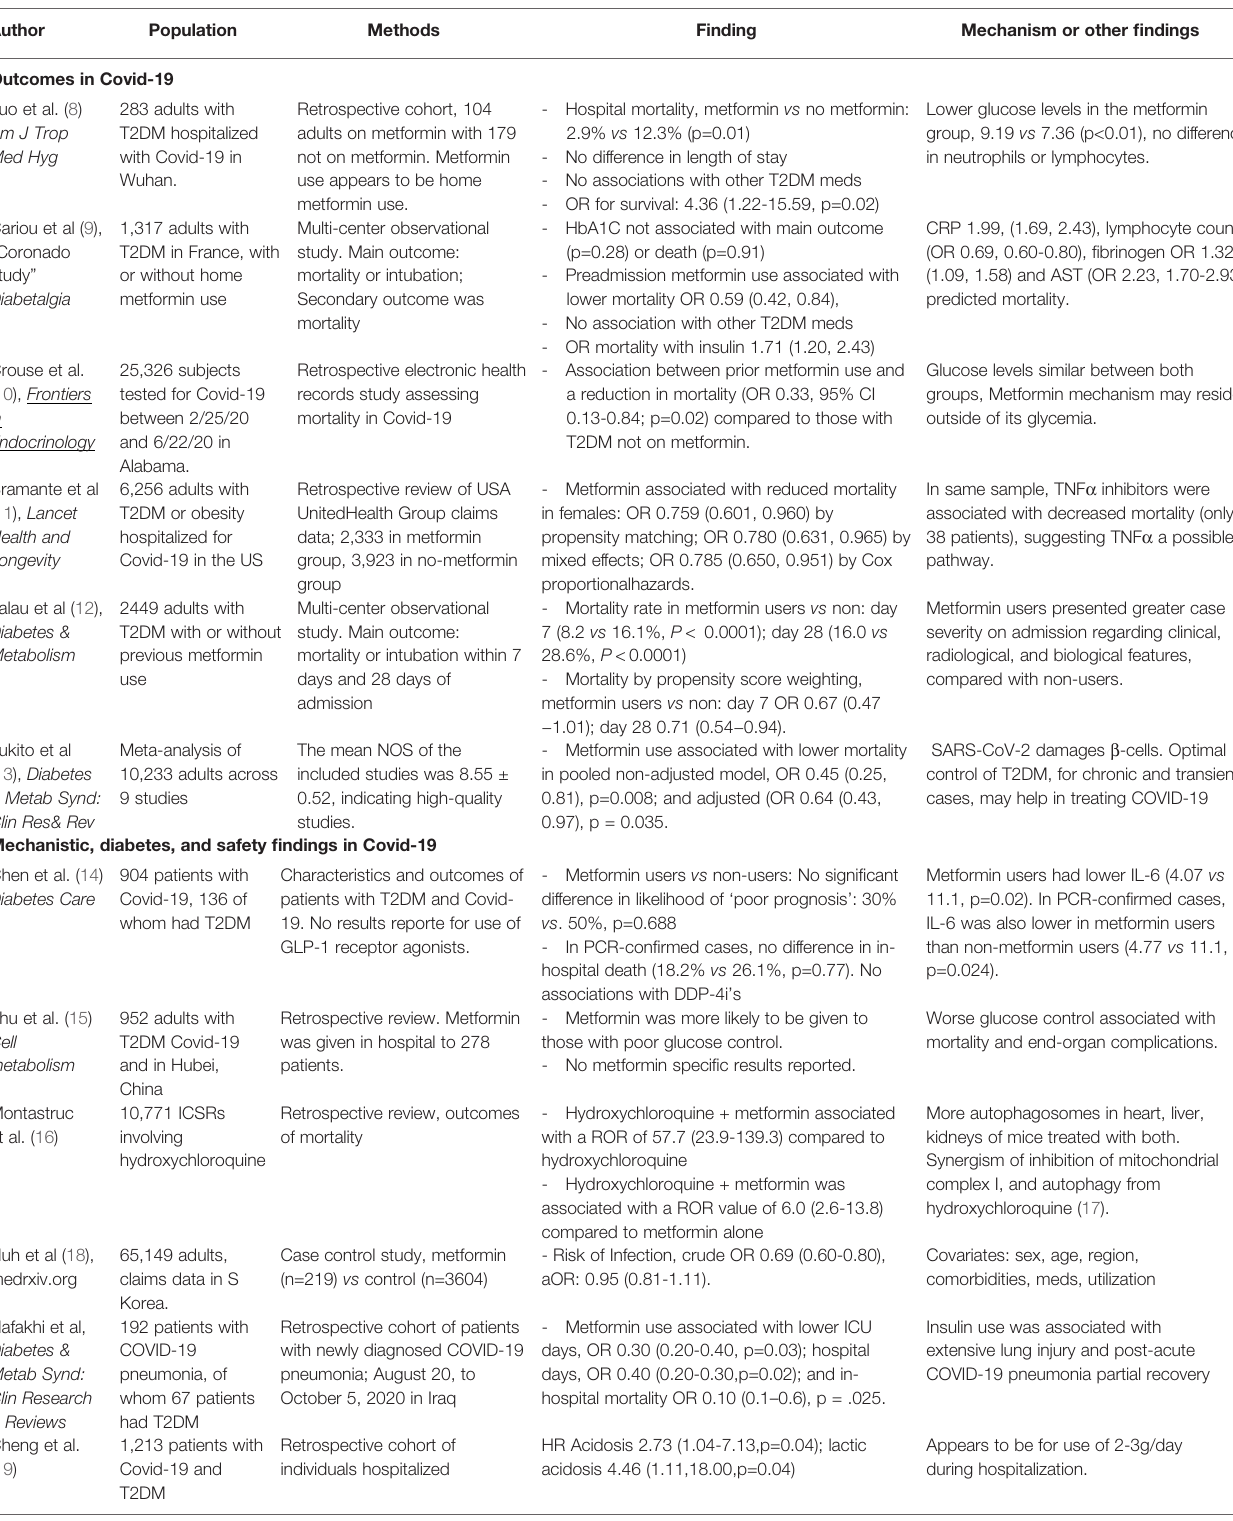
TABLE 1 | Overview of papers in 2020 with fi ndings related to metformin and